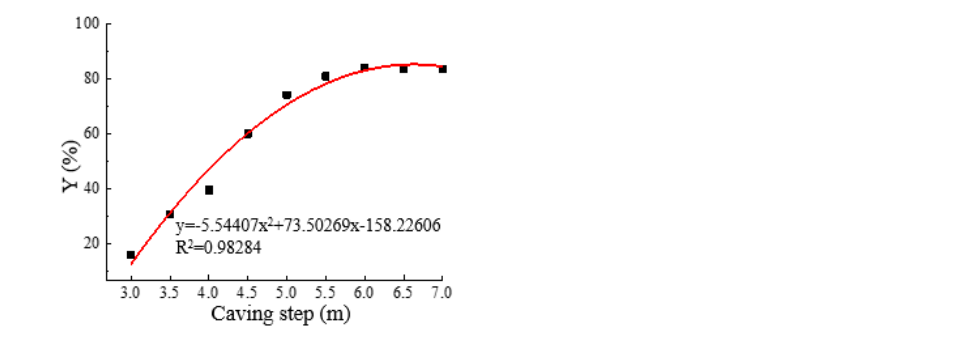
Figure 13. Relationship of the difference between recovery and dilution ratio Y and caving